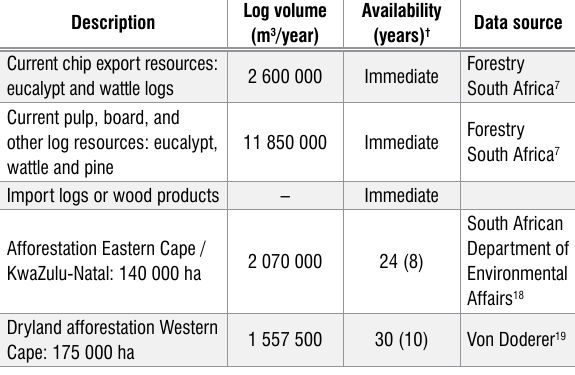
Research study results on building system embodied energy and global warming potential impacts Building system